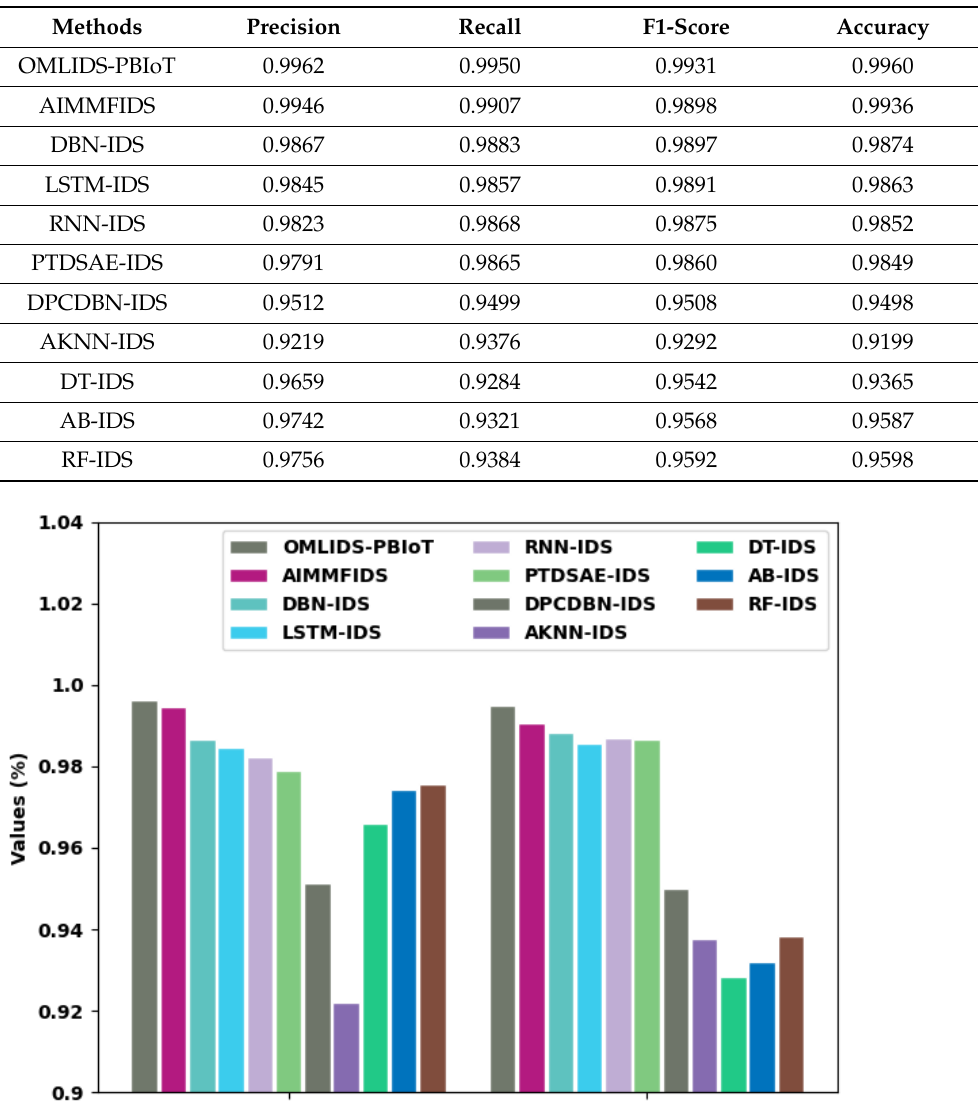
Table 4. Comparative analysis of OMLIDS-PBIoT method with existing approaches.